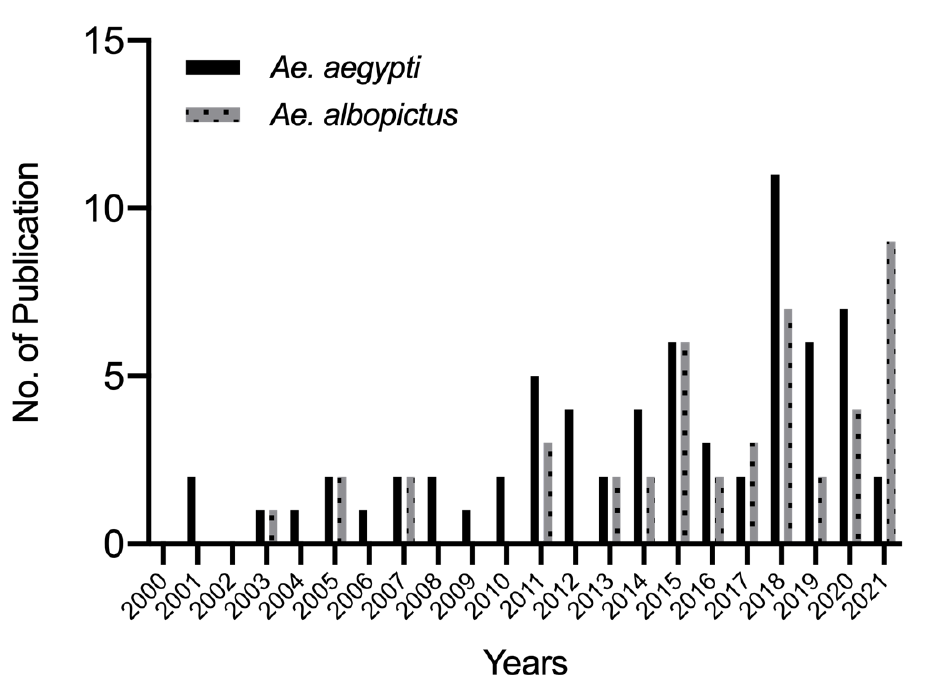
Figure 2. Temporal patterns of publications.